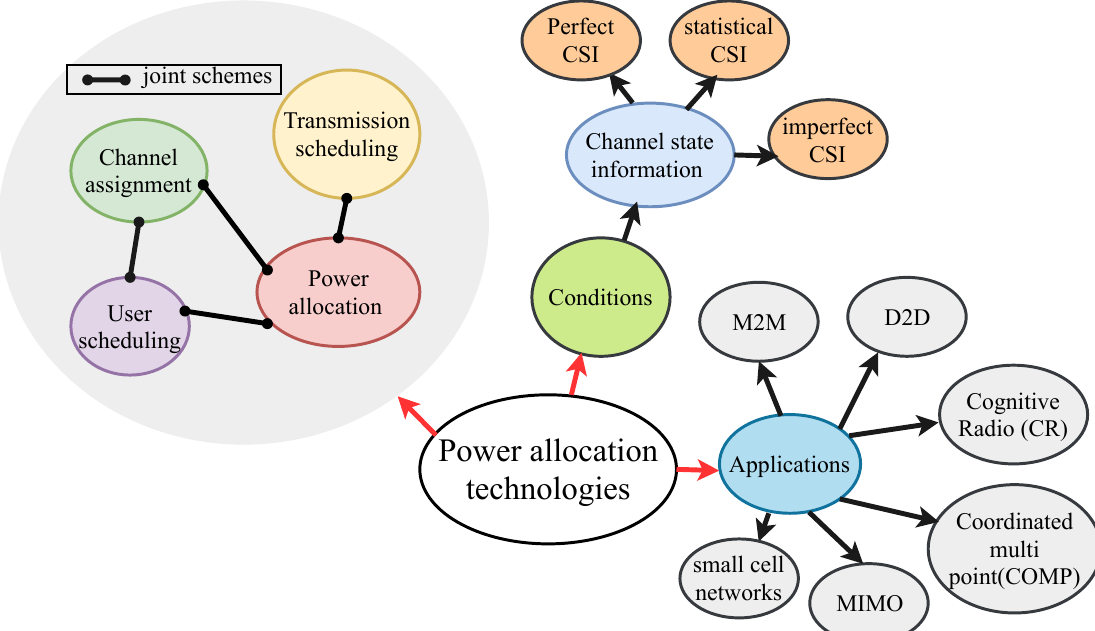
Figure 3. Classification of energy efficient green technologies for NOMA under power allocation